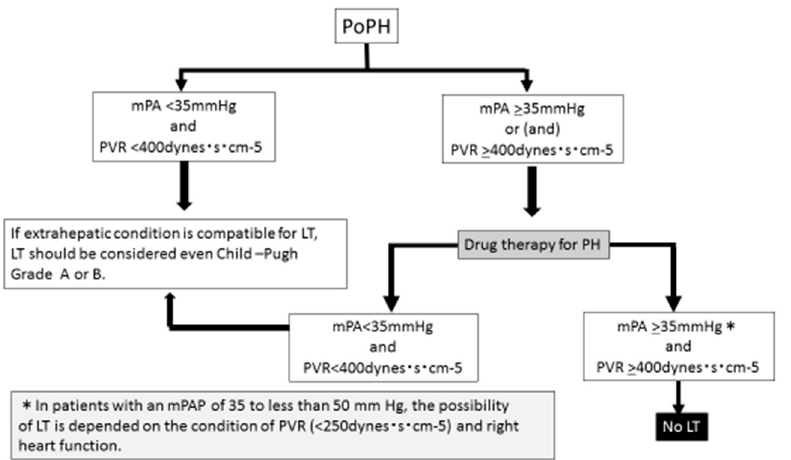
Figure 4. Flowchart of indications for LT in patients with PoPH. LT, liver transplantation; mPAP, mean pulmonary arterial pressure; PVR, pulmonary vascular resistance.